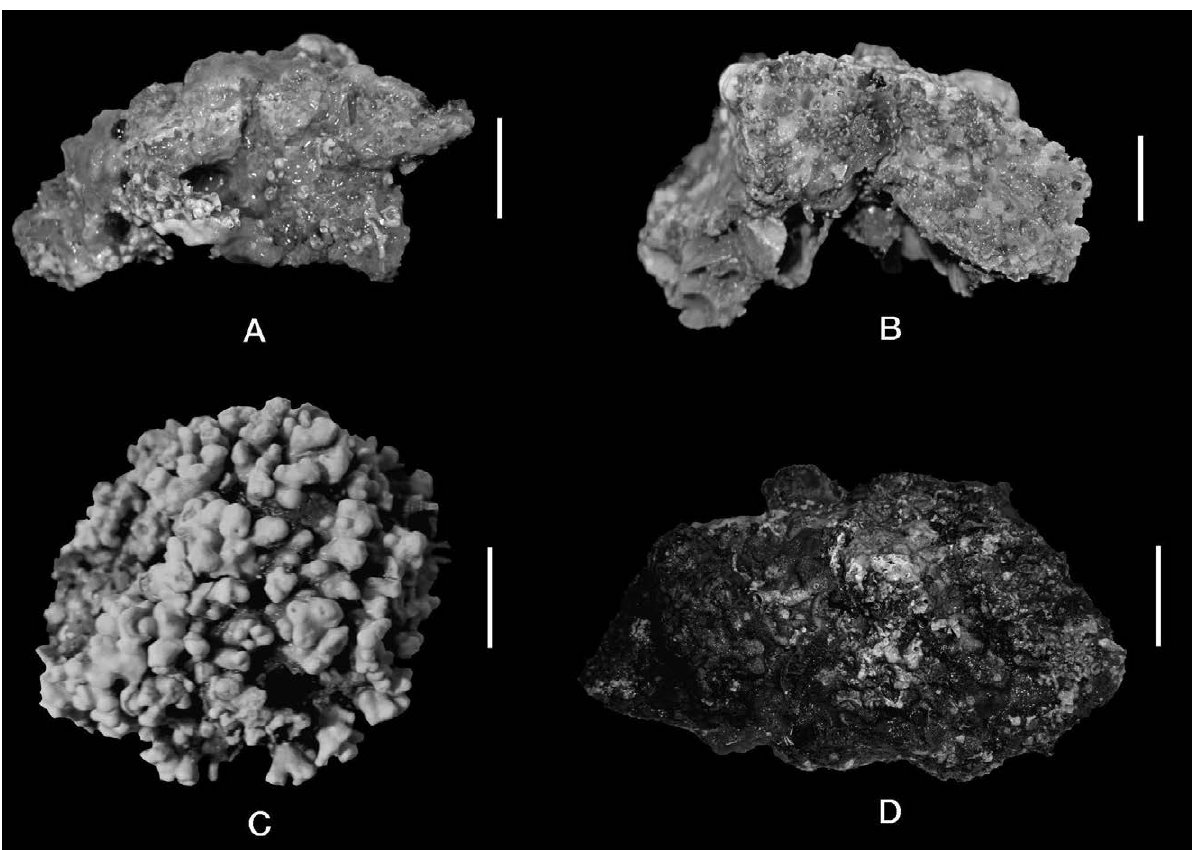
Fig . 4. – A, Acarnus michoacanensis n. sp. Preserved specimen growing over coral frame. B, Acarnus oaxaquensis n. sp. Preserved encrust- ing sponge growing over coral frame. C, Acarnus sabulum n. sp. Preserved specimen growing over rhodolits. D, Acheliderma fulvum n. sp. Preserved encrusting sponge. Scale: A, B, C, 1 cm; D, 2